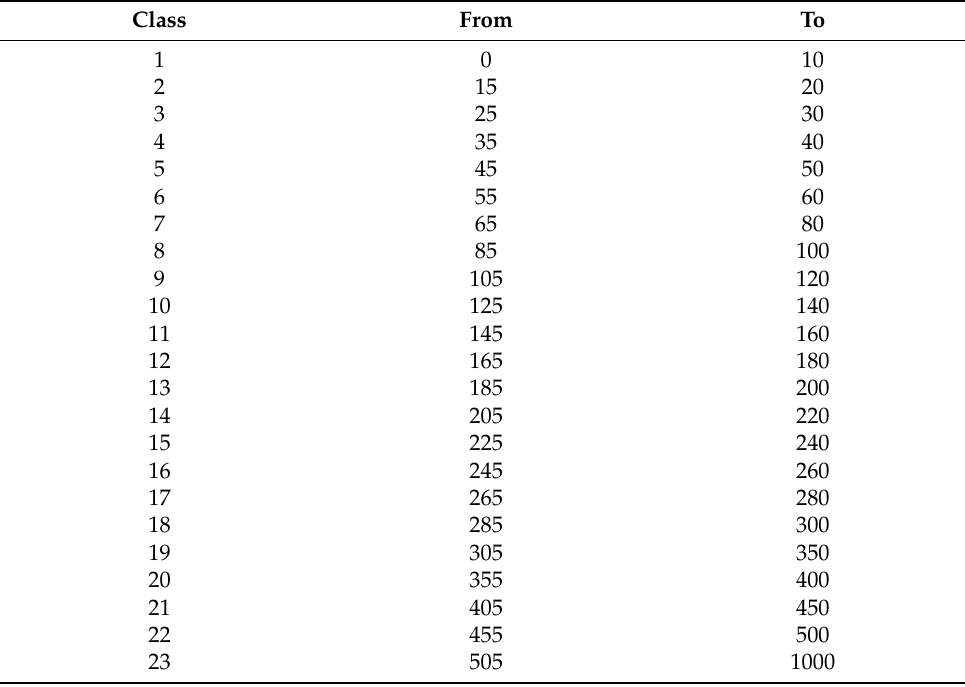
Table A1. Classification of the pores by size ( µ